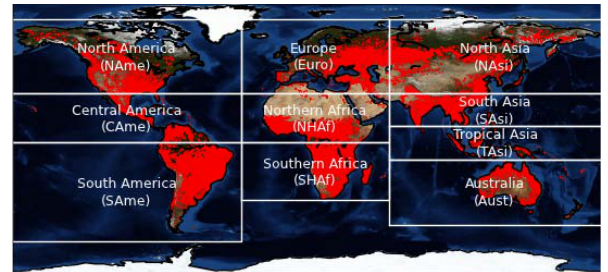
Figure 11. Regional partitions as defined in Kaiser et al. (2012) that are used in this paper to compare FEER.v1 emissions with GFED.v3, GFAS.v1, and QFED.v2 emission inventories. The back- ground MODIS true-color image shows fire locations (red dots) de- tected by MODIS from both Terra and Aqua for all of 2010, to il- lustrate the global spatial distribution of annual fire